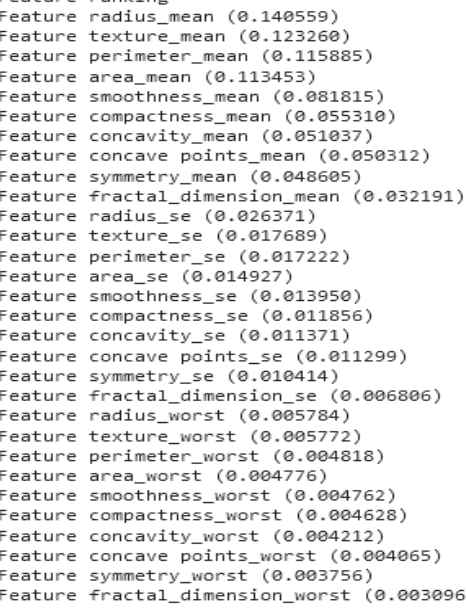
Figure 5. Feature ranking scores.